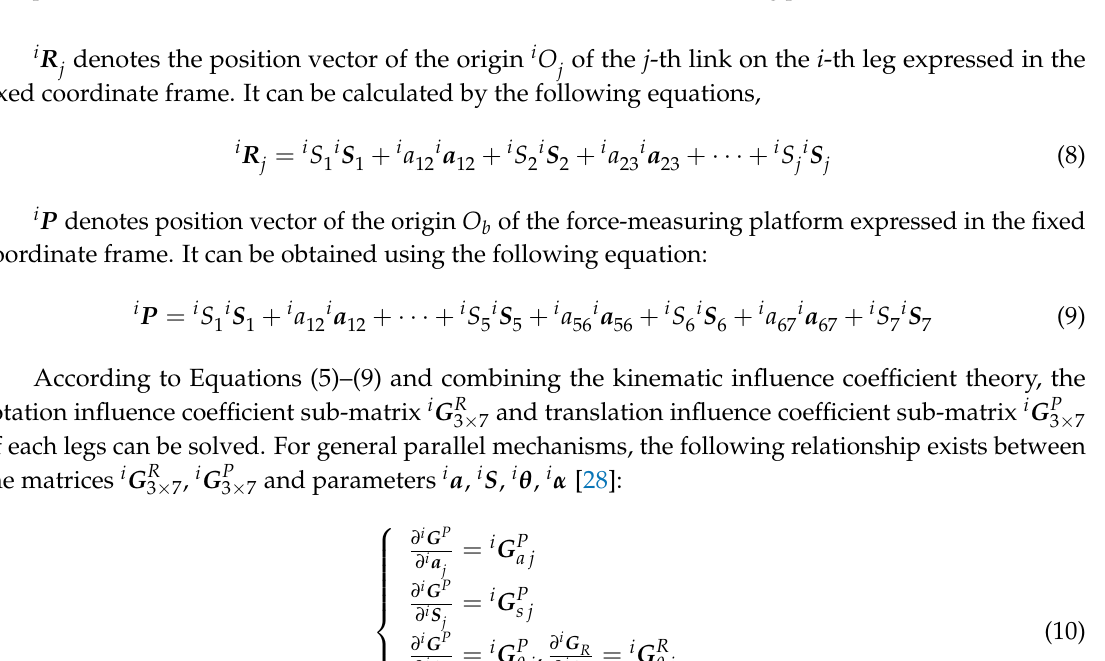
Figure 6. Diagram of imaginary prismatic joints. ( a ) Coordinate frame establishment of the fixed platform radius error; ( b ) Coordinate frame establishment of the measuring platform radius error.